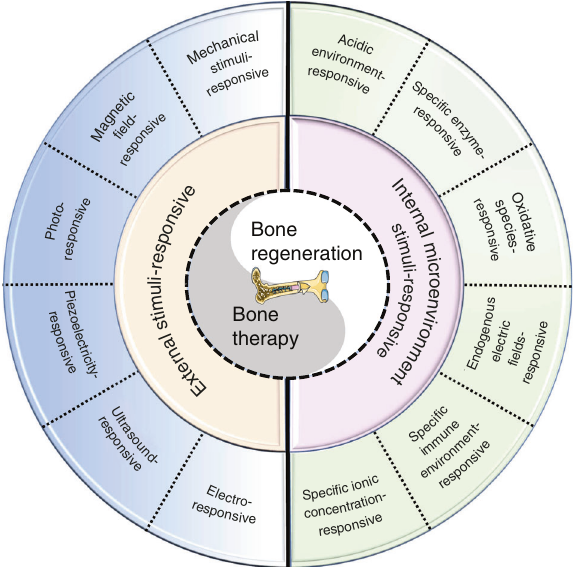
Fig. 1 Scheme summarizing different strategies in the design and fabrication of versatile biomaterials with both therapeutic and regeneration